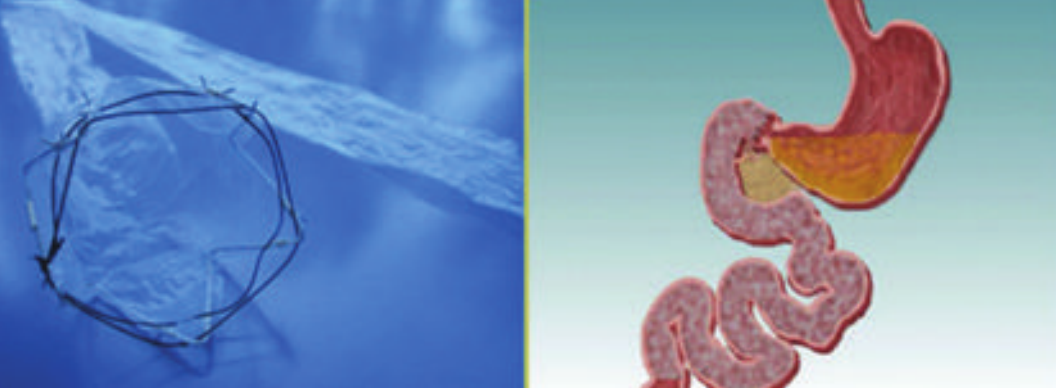
Figure 6: The EndoBarrier gastrointestinal liner. Food bypasses the duodenum and proximal jejunum as it does in a Roux-en-Y Gastric Bypass.